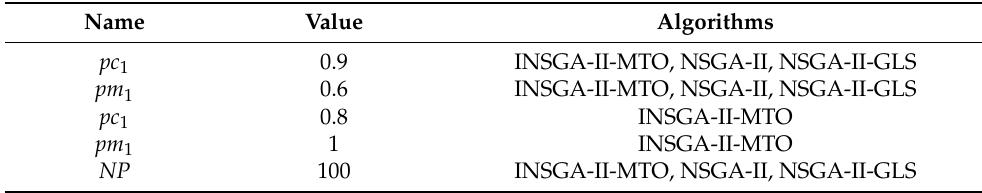
Table 2. HV results of all comparison algorithms in three